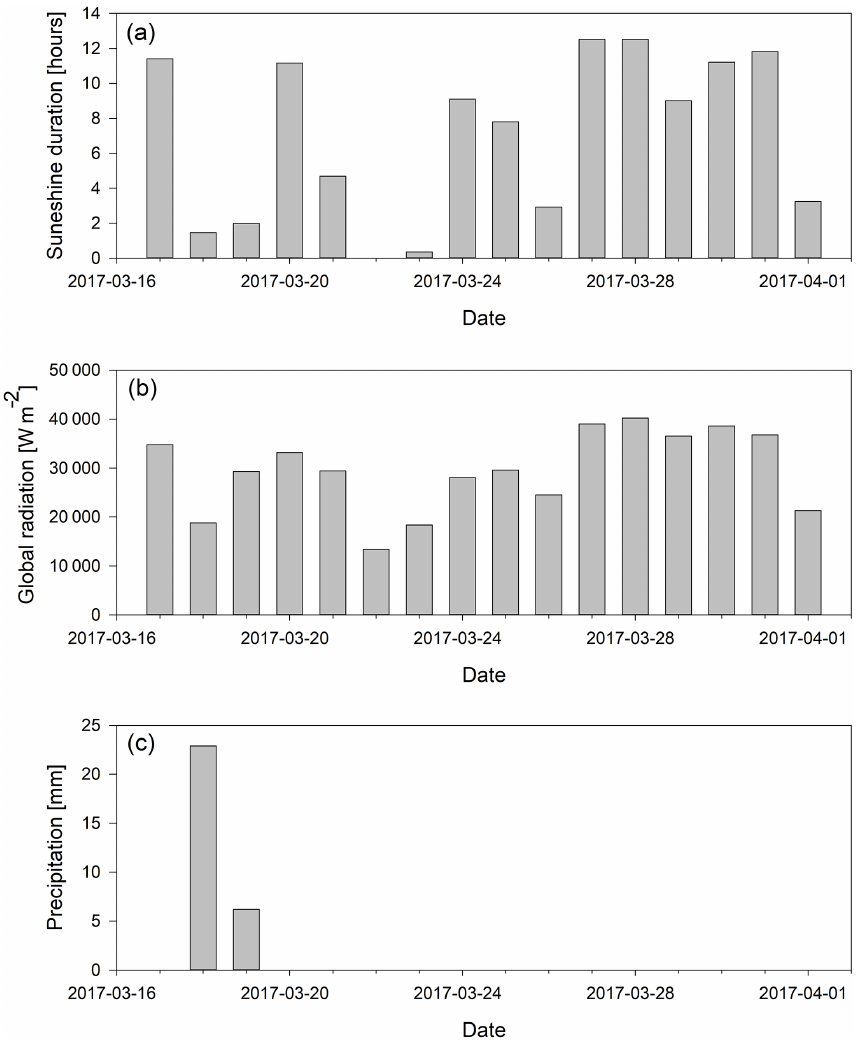
Figure A1. Light conditions and precipitation during the sampling period. (a) Global radiation (Wm − 2 ) integrated for each day; (b) total daily sunshine duration in hours; (c) precipitation for the sampling